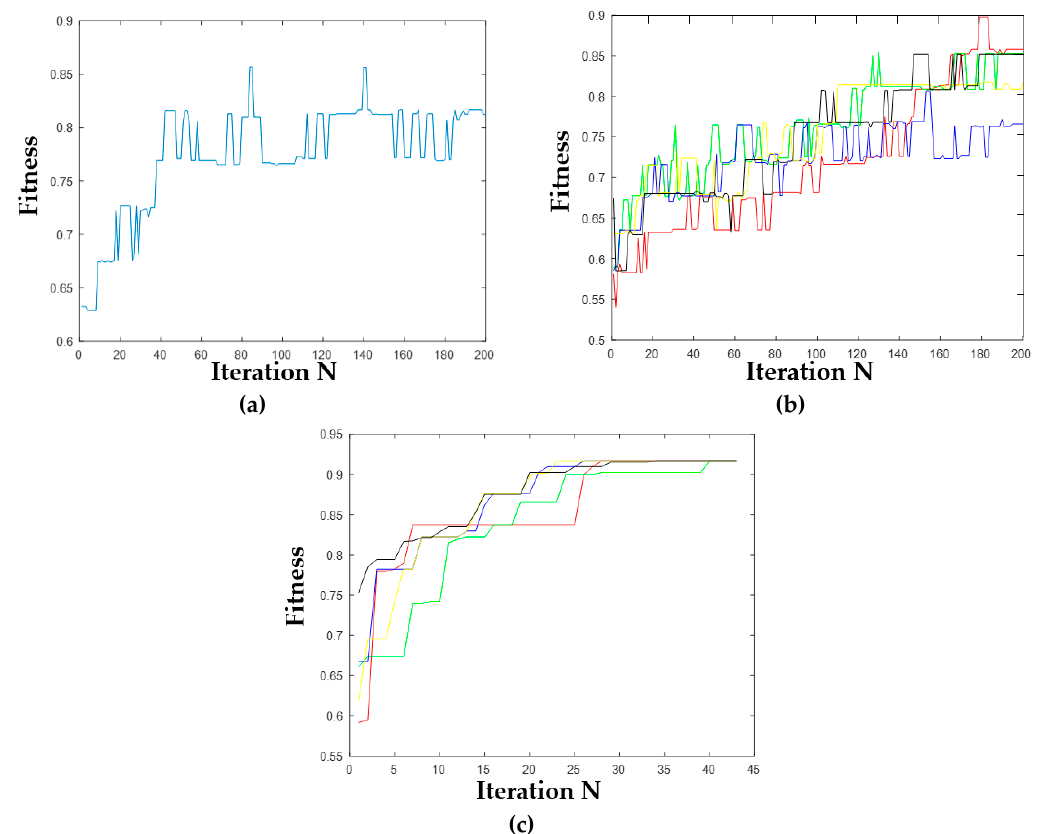
Figure 2. The evolutionary process of di ff erent algorithms: ( a ) Evolutionary process of the traditional genetic algorithm; ( b ) evolutionary process of the multi-population genetic algorithm; ( c ) evolutionary process of IMPGA.